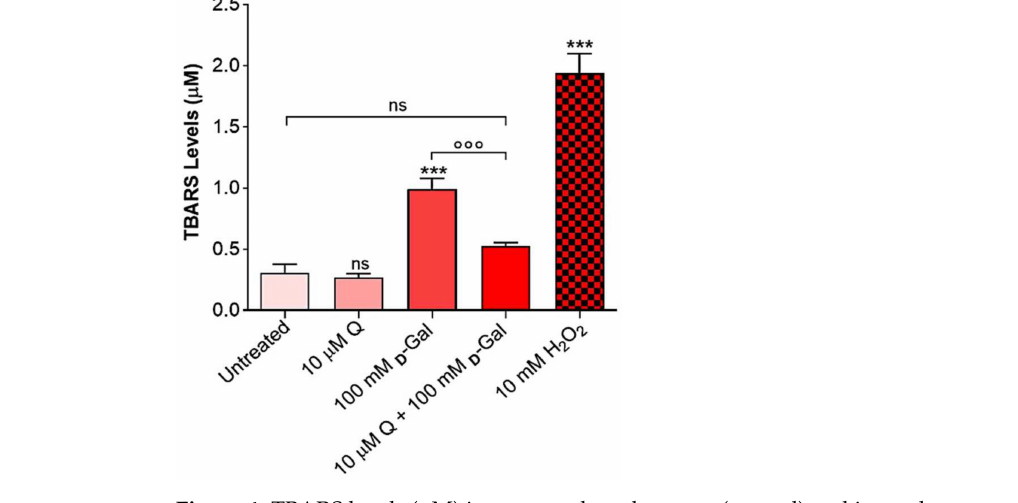
Figure 4. TBARS levels ( µ M) in untreated erythrocytes (control) and in erythrocytes treated for 24 h with 100 mM D -Gal, or, alternatively, with 10 µ M Q (pre-incubation for 1 h) with or without D -Gal. ns, not statistically significant versus untreated; ***, p < 0.001 significant versus control; ◦◦◦ , p < 0.001 versus 100 mM D -Gal, one-way ANOVA followed by Bonferroni’s post hoc test ( n = 5).